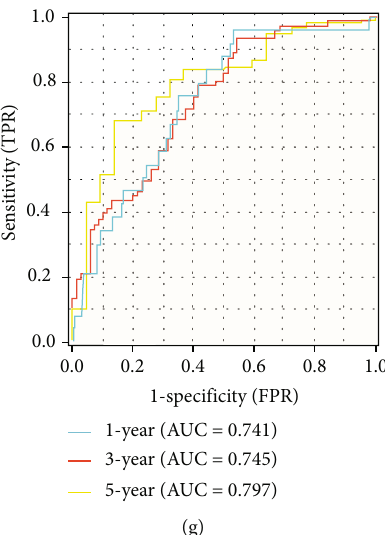
Figure 2: Construction of the PPAR-Riskscore prediction panel. (a) Identi fi cation of the prognostic PPAR-related genes by univariate Cox regression analysis; (b) identi fi cation of 4 prognostic PPAR-related genes by multivariate Cox regression analysis. (c) and (d) The distribution of PPAR-Riskscore and the survival status of patients with di ff erent scores. (e) Heatmap of the expression pro fi les of the genes in the prognostic signature. (f) The Kaplan-Meier curves of overall survival for patients between the high-risk group and low-risk group. (g) Time-independent receiver operating characteristic (ROC) analysis for evaluating the predictive performance of